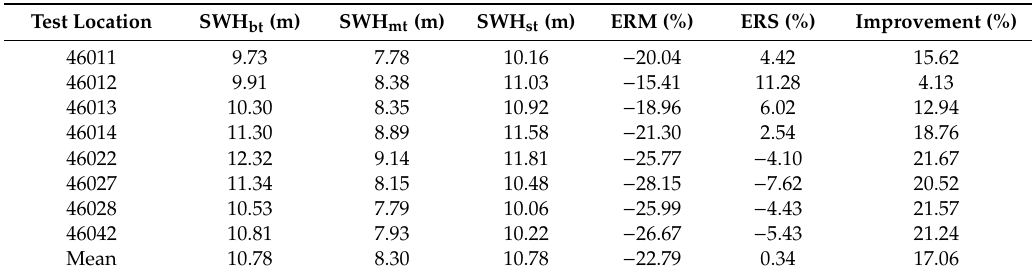
Table 2. Pacific Coast: results for T R = 100